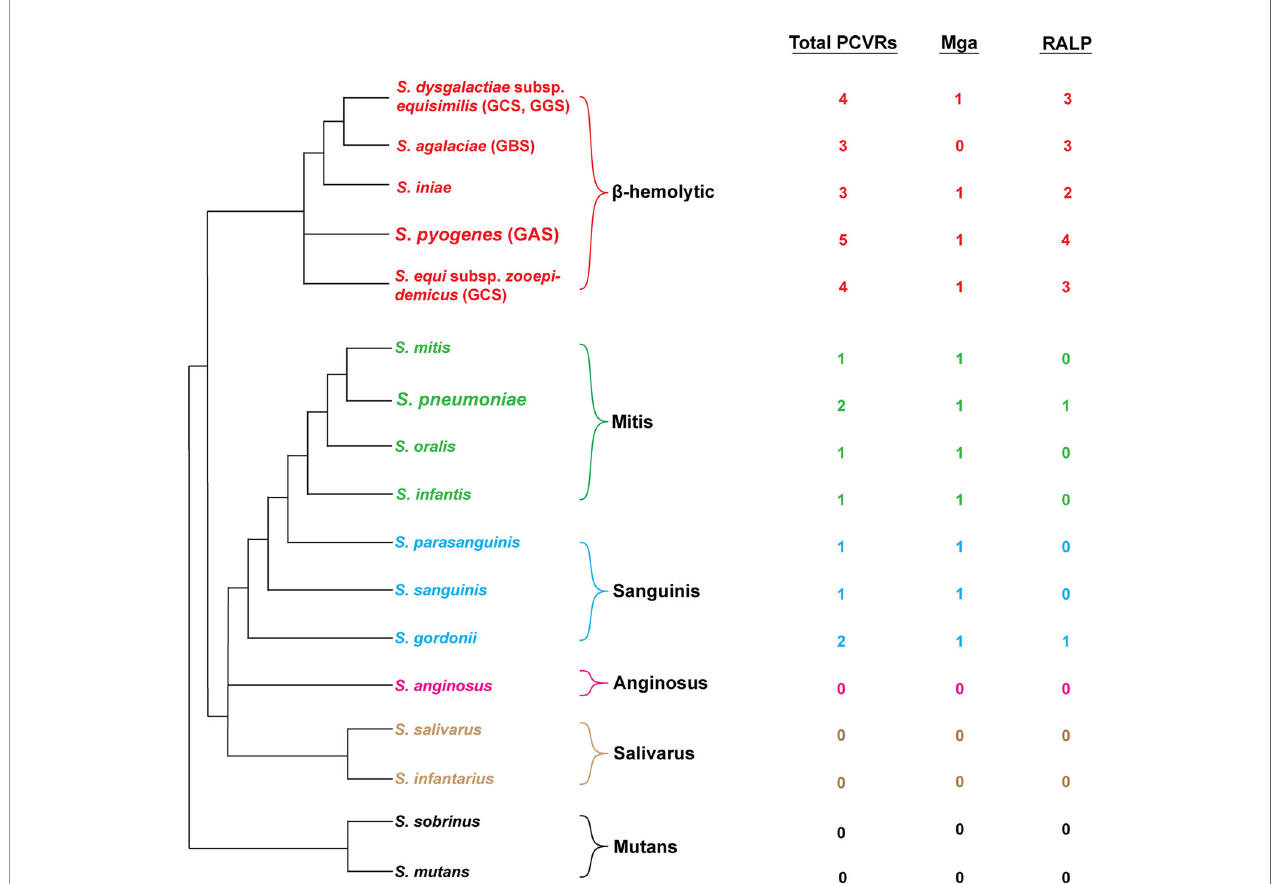
FIGURE 4 | Distribution of PCVRs in streptococcal species. Left: Depicted are the major streptococcal species and clades organized based on their evolutionary divergence. Beta-hemolytic streptococci are located in the top clade in red. Divergent viridans species are organized below. Right: The abundance of Mga/RALP (red) or Mga/RALP-like (green/blue/pink/tan/black) PCVRs are listed for each respective streptococcal species. The Mga/RALP-like PCVRs were identi fi ed based on sequence similarities to the M1 S. pyogenes strain 5448 using BLAST